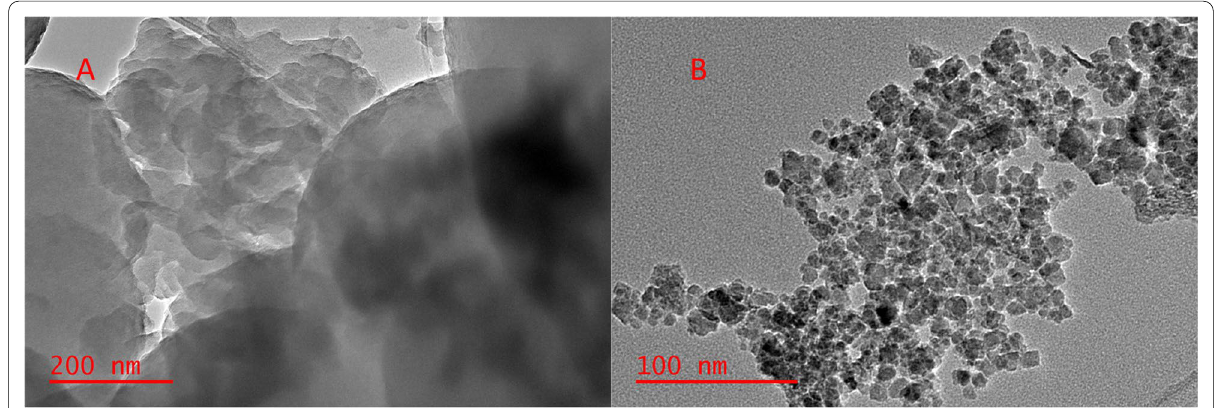
Fig. 5 TEM images indicating the internal morphologies of a PABA/AC and b Fe 3 O 4